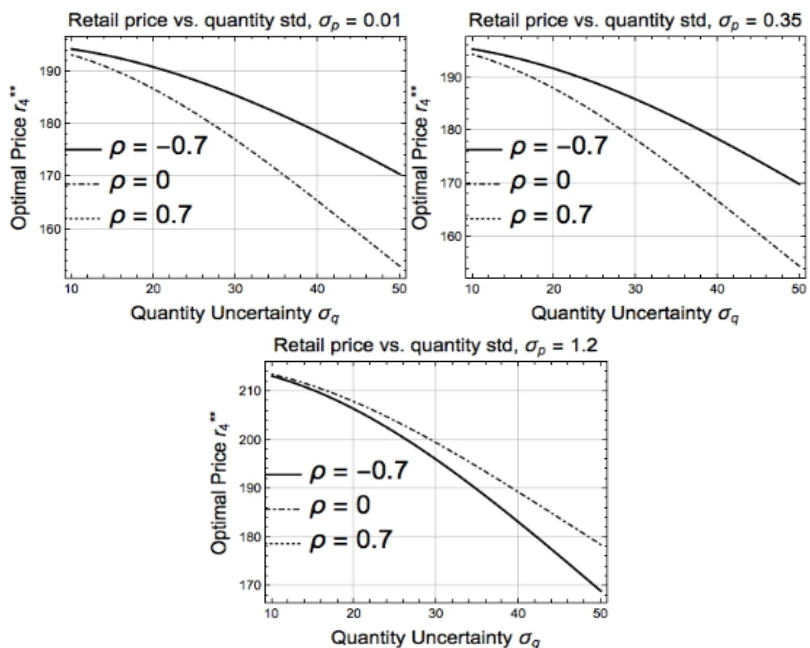
Figure 6. Comparison of 𝑟 (cid:2870)∗ from Theorem 2 as a function of quantity volatility σ (cid:2927) under small (top- left, σ (cid:2926) = 0.01 ), medium (top-right, σ (cid:3043) = 0.35 ), and large (right, σ (cid:3043) = 1.2 ) price volatility. In each plot, the three correlation conditions ( ρ = −0.7, ρ = 0, ρ = 0.7 ) are also described.